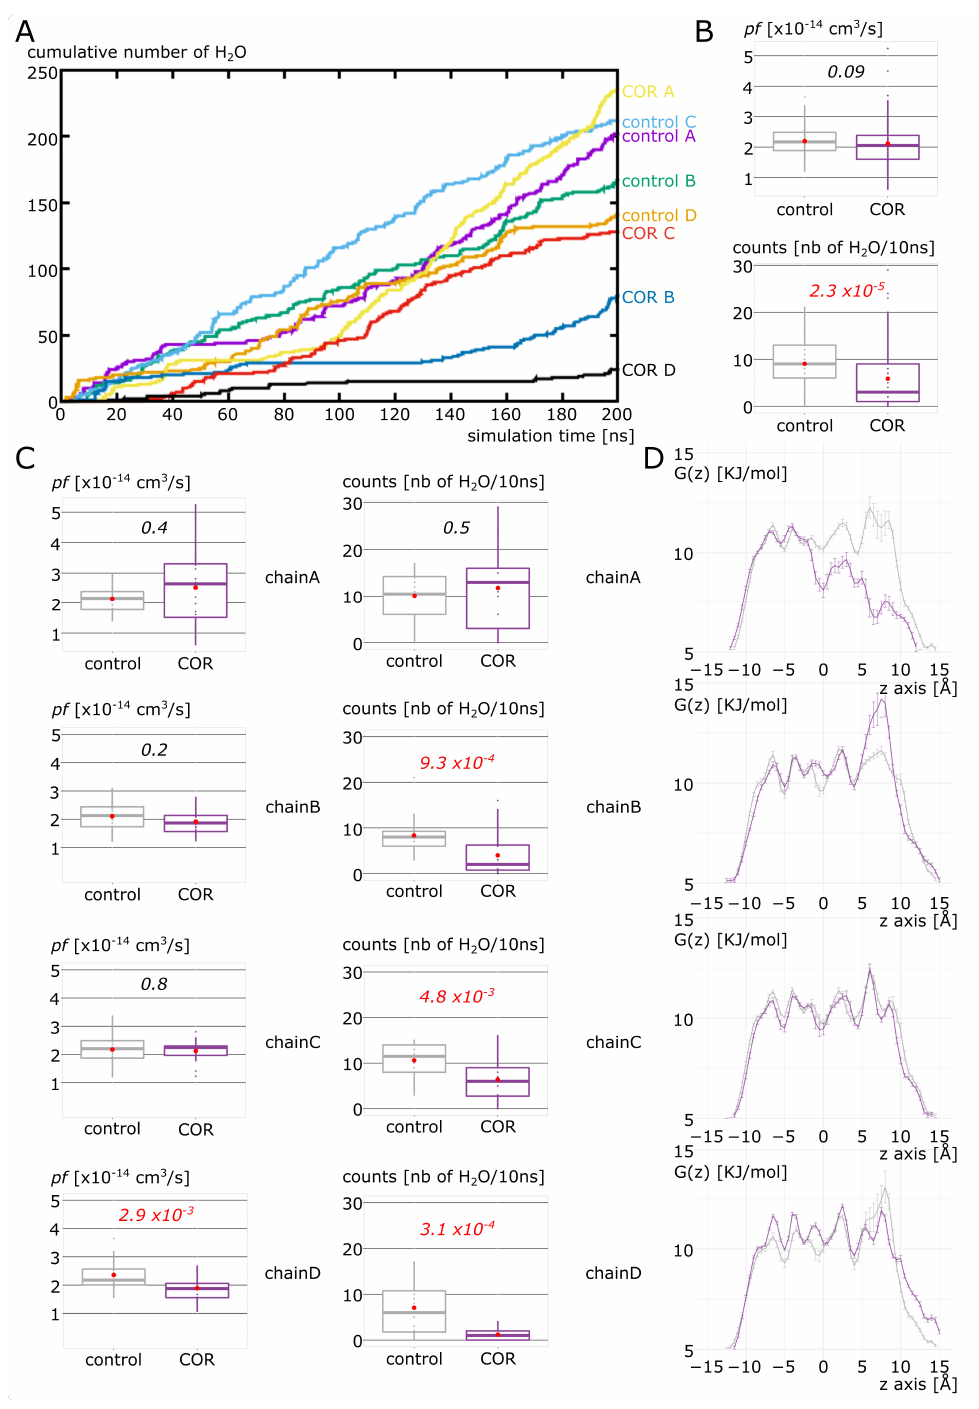
Figure 3. Impact of cortisol on AQP2 water permeability. ( A ) Cumulative number of water crossing the whole transmembrane pore section of 30 angströms as a function of simulation time. Both conditions “control” and “COR” are represented. ( B ) Osmotic permeability coefficient (pf) and number of water crossing the entire 30 angströms-long pore section compared between “control” and “COR” conditions. ( C ) Same water permeability indicators between the two conditions for each monomer (chain A, chain B, chain C and chain D). For statistical comparisons, non parametric Mann–Whitney test was performed, and p values are indicated in italic and colored in red when corresponding to alpha < 0.05. ( D ) Water free energy profiles centered on the center of the conducting pore and zoomed over the 30 angströms-long transmembrane section used to count water permeations for each monomer. “Control” condition is represented in gray and “COR” condition in